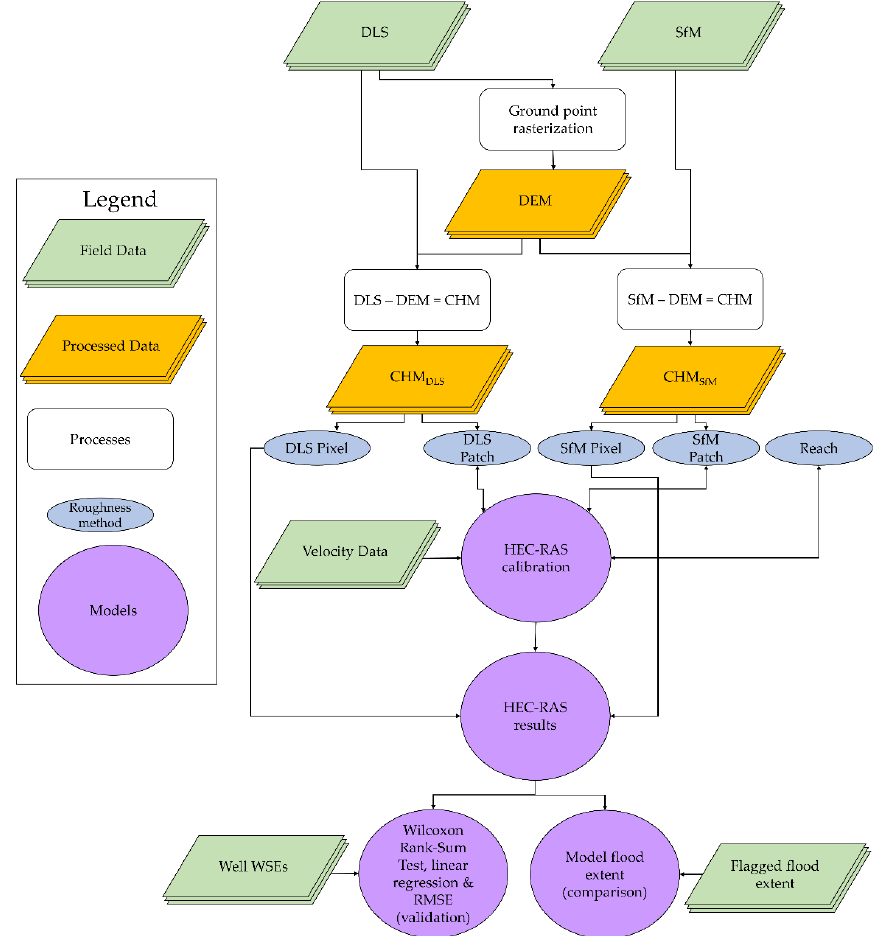
Figure 5. Workflow showing how remotely sensed data were manipulated for use in each roughness raster creation, as well as how models used each raster along with field data calibration (velocity data), validation (well WSEs), and comparison (flagged flood extent).